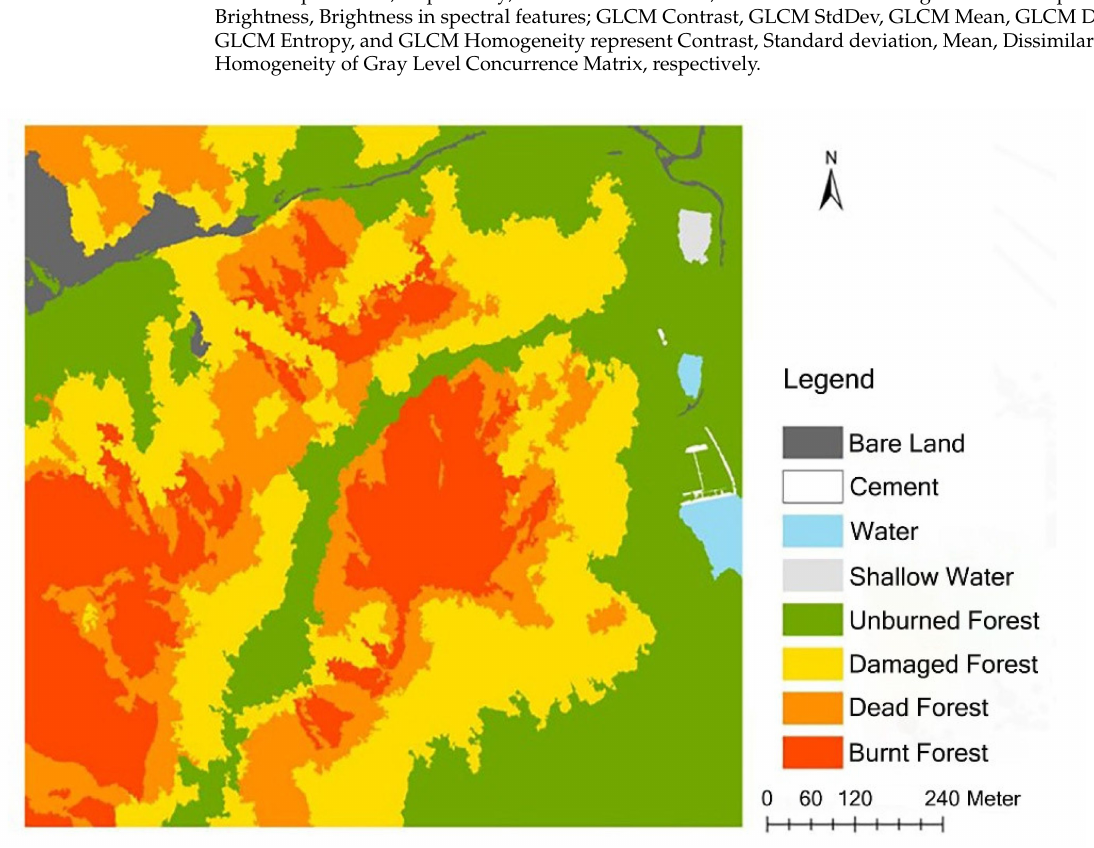
Figure 6. The classification of forest burn severity based on the object-oriented